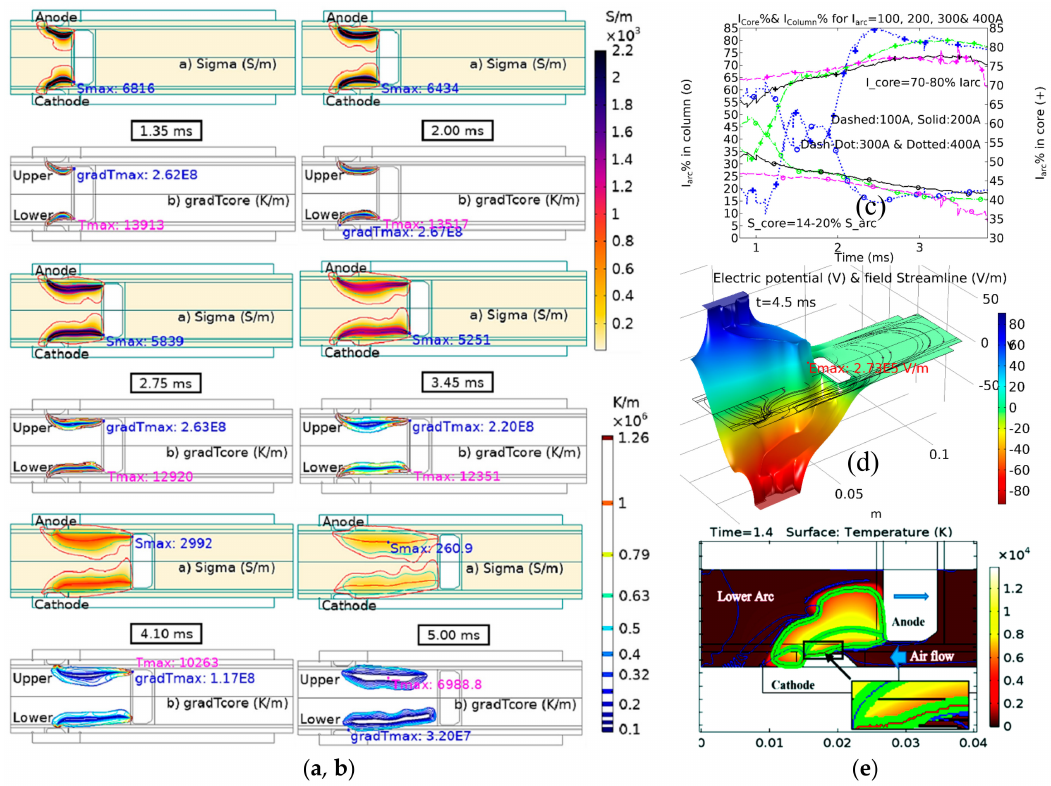
Figure 8. ( a ) σ contours and the point of maximum σ , ( b ) Contours of T-gradient at 1.35, 2, 2.75, 3.45, and 5 ms in an arc of 200 A peak , ( c ) Percentage of I arc = I source divided between core / column, ( d ) Electric potential and electric field at 4.5 ms showing anodic and cathodic V d , and ( e ) Zero gradient contours for J norm (green), σ (red) and T (blue) at 1.4 ms on the T-surface.